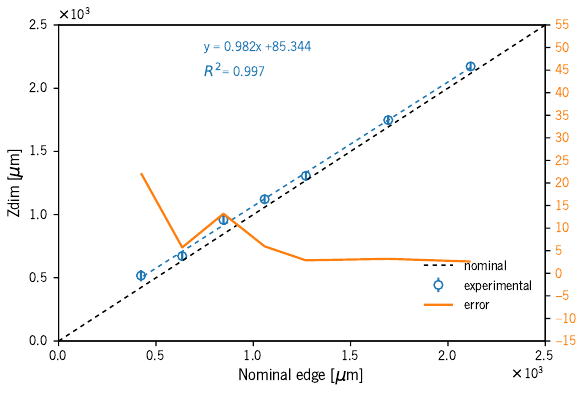
Figure 10. Experimental mD measurements diagrams with linear fit and relative error for specimens A01S to A07S: ( a ) AreaH; ( b ) AreaV; ( c ) XDim; ( d ) YDim; ( e ) ZDim.